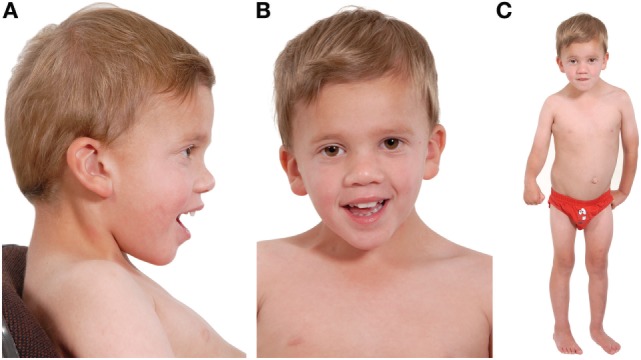
Three photographs of our patient taken at the age of 4 years. Photograph (A) shows a low posterior hairline with low-set posteriorly rotated ears, microcephaly, and mild frontal bossing. Photograph (B) shows down-slanting palpebral fissures and mild ptosis. He has dental crowding and a narrow, high-arched palate (not shown). Photograph (C) shows lasting damage from his cerebral infarct: the right upper limb is flexed and there is reduced muscle tone of the thigh in comparison to the left lower limb. His neck appears broad, with a broad thorax and wide-spaced nipples. His spleen measures 12 cm and marginally distorts the appearance of the abdomen. His skin is soft and mottled and he has clinodactyly. He is <0.4th centile for height, weight, and head circumference, and developmentally he is predicted to have skills appropriate for a 2½–3-year old. Noteworthy, during the antenatal period, marginal nuchal fold enlargement was documented but otherwise pregnancy and delivery were uneventful.